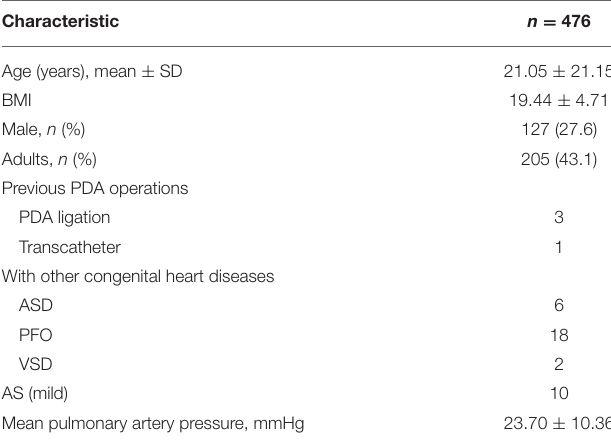
TABLE 1 | Baseline characteristics of